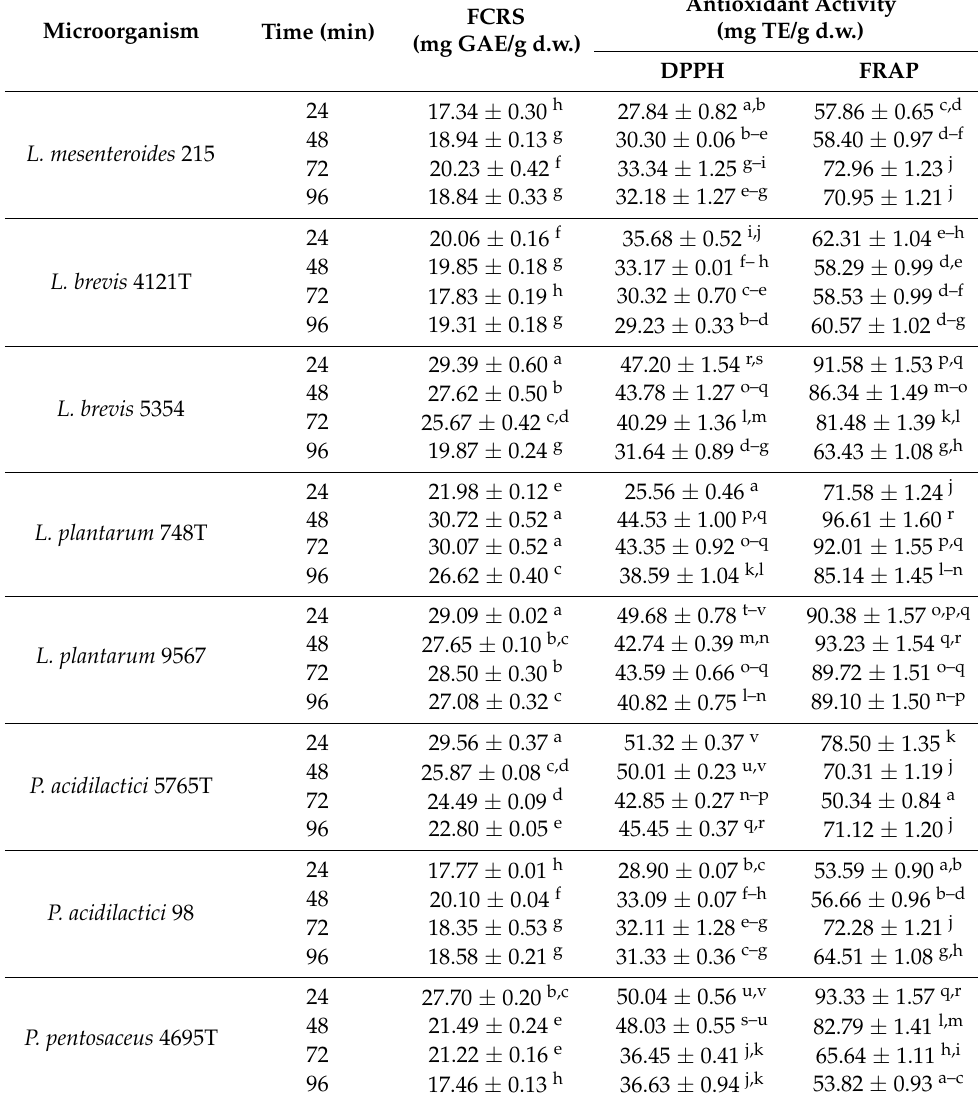
Table 1. Folin–Ciocalteu reacting substances’ content and antioxidant activity of all the strains tested from 24–96 h in avocado leaves and a control. Results are expressed as average ± standard deviation. FCRS Microorganism Time (min) (mg TE/g (mg GAE/g d.w.)